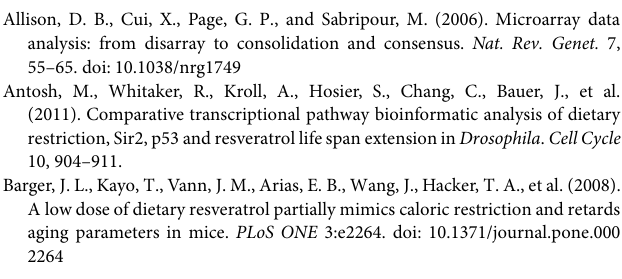
Table S3 | Cell processes enriched in the gene list. Sheet 1: Cell processes enriched in the common genes between RSV and CR in visceral adipose tissues of DIO zebrafish. Sheet 2: Cell processes enriched in the common genes between RSV and CR in subcutaneous adipose tissues of obese humans. Sheet 3: Cell processes enriched in the common genes dysregulated in visceral adipose tissues of female and male DIO zebrafish. Sheet 4: Cell processes enriched in the common genes dysregulated in subcutaneous adipose tissues of obese human females and males. Sheet 5: Cell processes enriched in HDAC2, EP300, CEBPB, CEBPD, FOXA1, FOXA2, NR2F2, and POLR2A. Sheet 6: Common cell processes enriched in genes between RSV and CR, in genes between obese females and males, and in eight regulators. Table S4 | Transcriptional regulators identified by iRegulon. Sheet 1: Transcriptional regulators identified by iRegulon for the common genes between RSV and CR in visceral adipose tissues of DIO zebrafish. Sheet 2: Transcriptional regulators identified by iRegulon for the common genes between RSV and CR in subcutaneous adipose tissues of obese humans. Sheet 3: Transcriptional regulators identified by iRegulon for genes dysregulated in common between female and male DIO zebrafish. Sheet 4: Transcriptional regulators identified by iRegulon for genes dysregulated in common between obese human females and males. Table S5 | Transcriptional regulators identified by Pathway Studio. Sheet 1: Transcriptional regulators identified by Pathway Studio for the common genes between RSV and CR in visceral adipose tissues of DIO zebrafish. Sheet 2: Transcriptional regulators identified by Pathway Studio for the common genes between RSV and CR in subcutaneous adipose tissues of obese humans. Sheet 3: Transcriptional regulators identified by Pathway Studio for the common genes between female and male DIO zebrafish. Sheet 4: Transcriptional regulators identified by Pathway Studio for the common genes between female and male DIO